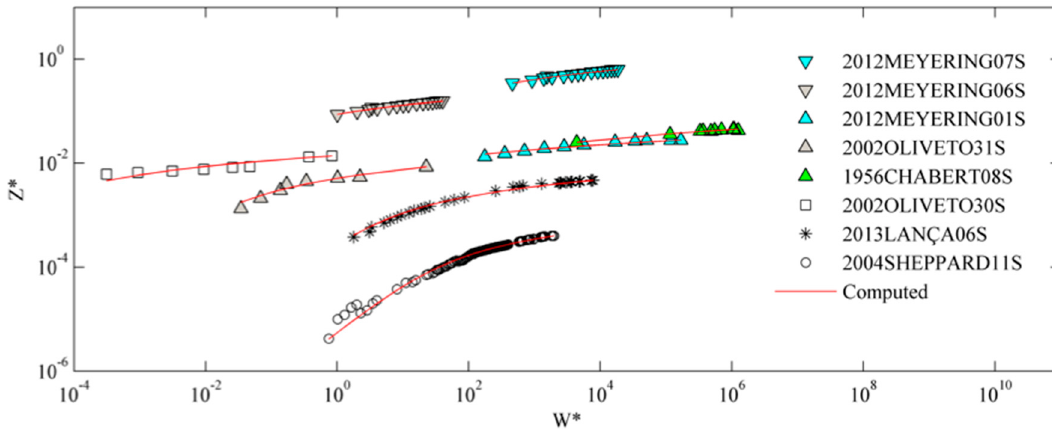
Figure 2. Measured (markers) and computed scour depth evolution using BRISENT model (red line) for experiments with extreme values of D ∗ , ρ (cid:48) , D / d 50 , h / D , and u / u c .